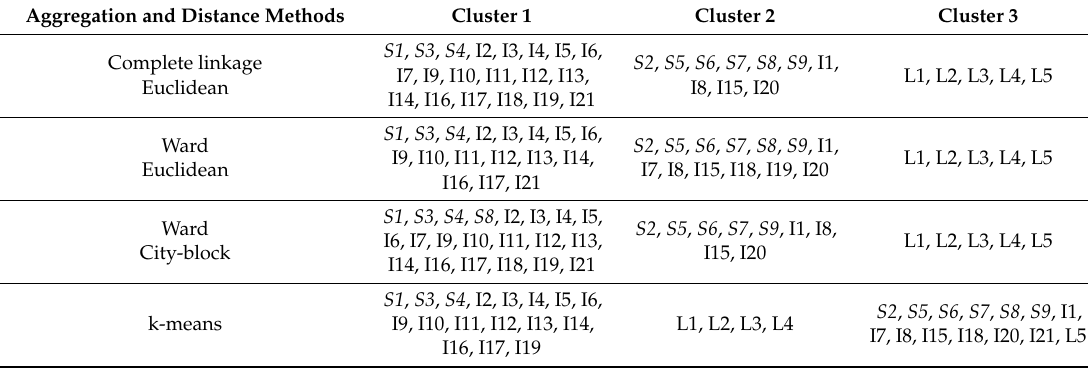
Table 9. Mixes composition of each cluster, for 3 clusters: hierarchical and non-hierarchical